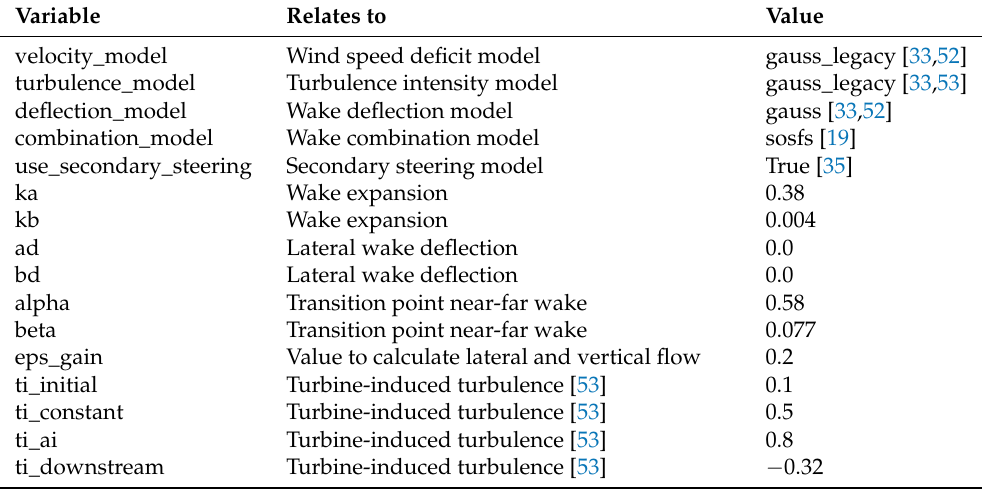
Table A1. Parameter and submodel choices in the FLORIS model